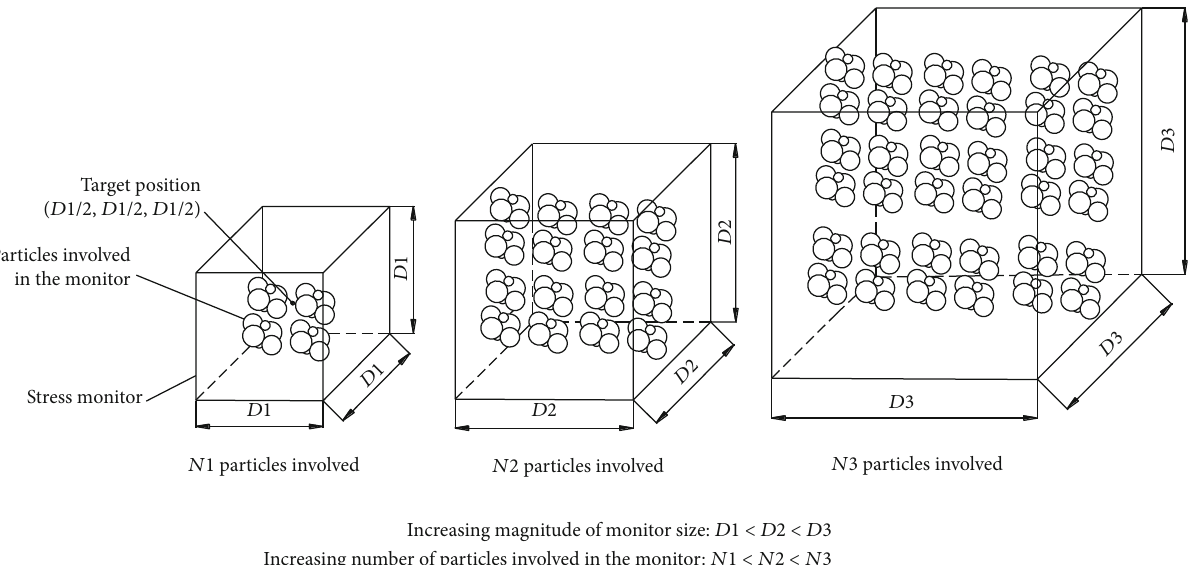
N 1 particles involved